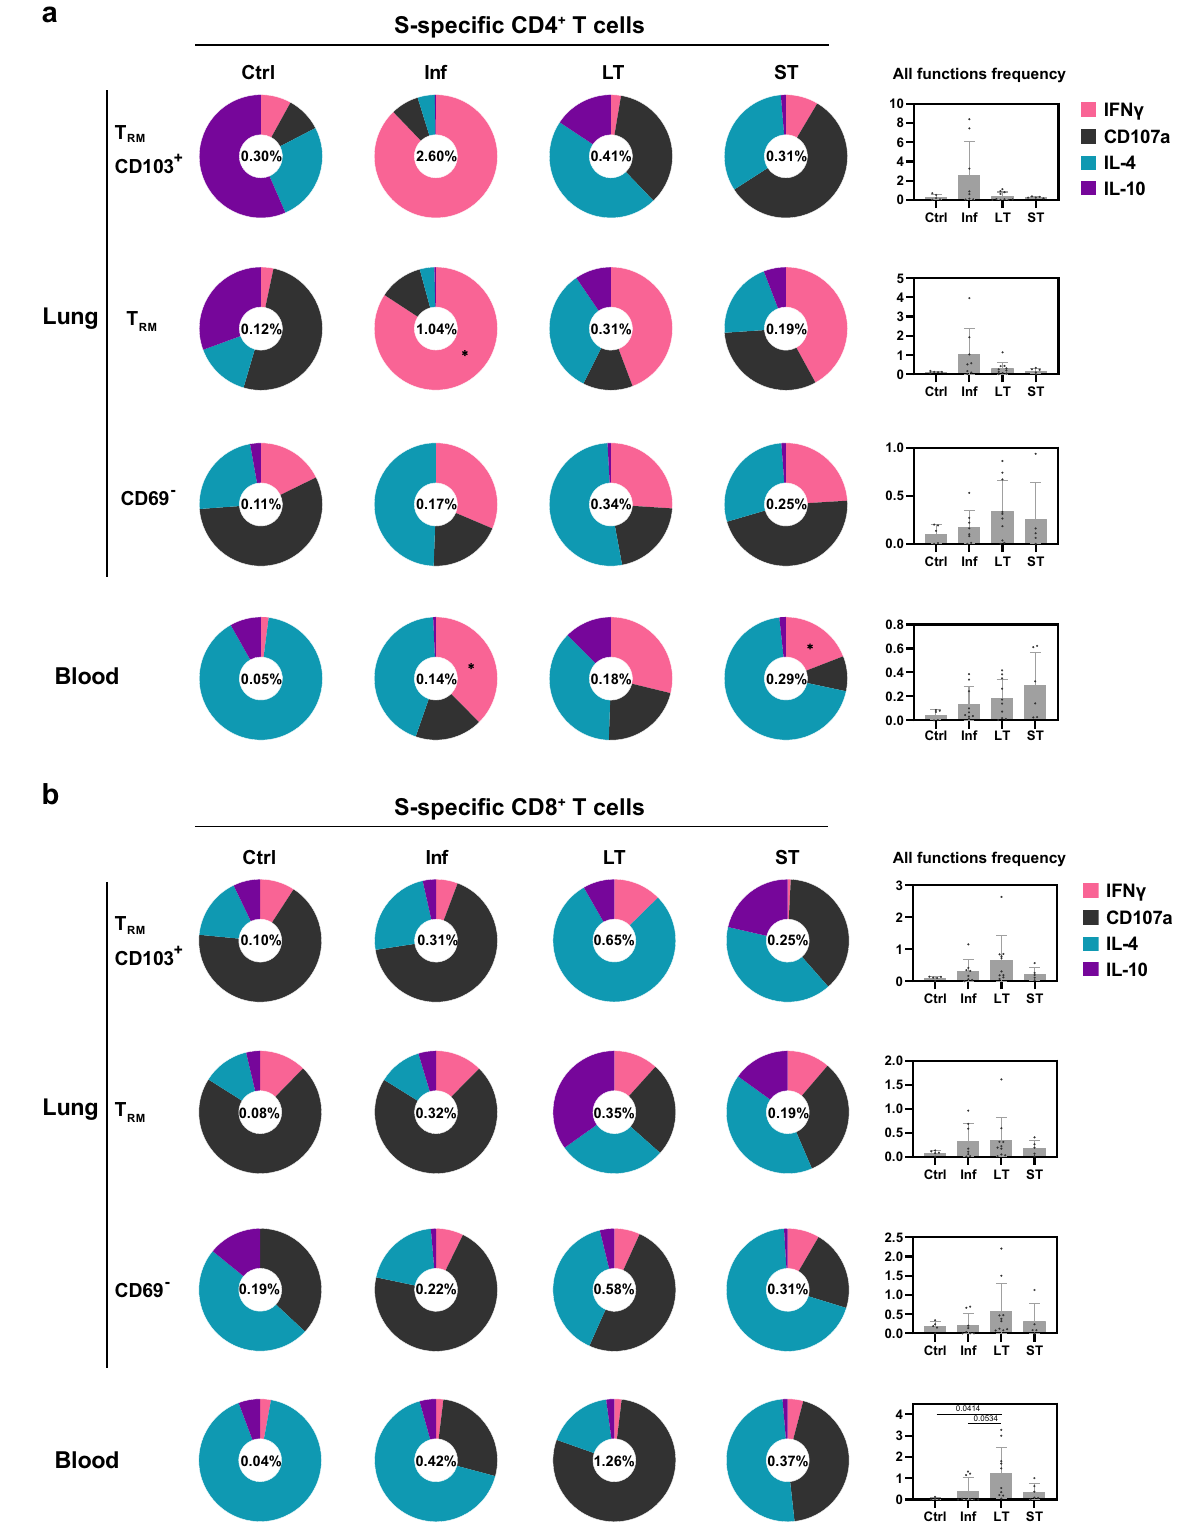
paired samples 3.7 months after infection, as well as 1.3 months after the third vaccine dose due to a second intervention for lung carci- noma, corresponding to a year after the initial infection (Supplemen- tary Fig. 10a). Neither of these two time points showed neutralization titers against omicron and antibody titers, instead of increasing after triple vaccination, decreased from 156 to 0 index for Ig against the N